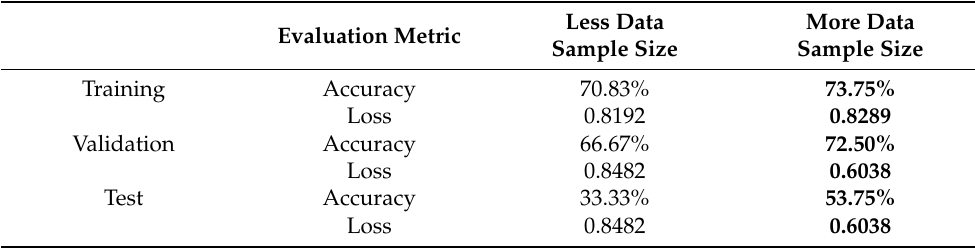
Figure 12. Different numbers of images for training, validation and testing in ResNet-like. ( a ) Dataset with more images and, ( b ) Dataset with fewer images. Table 2. The comparison of performance between smaller and larger sample sizes of data using ResNet-like batch 16. Larger sample size of data has better performance (as highlighted) compared to less data sample size.